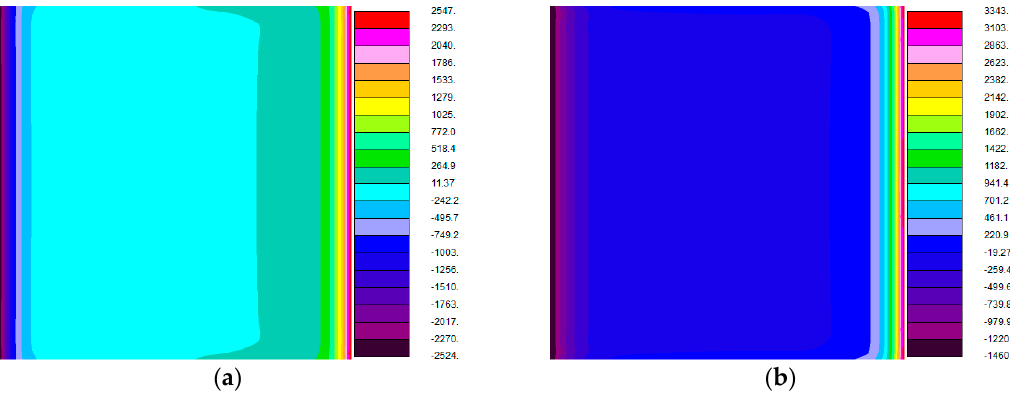
Figure 10. The plate LHC heat flux distributions of counter-flow plate heat exchanger heat transfer model with LHC ( a ) Balanced flow; ( b ) Unbalanced flow. Energies 2018 , 11 , x FOR PEER REVIEW